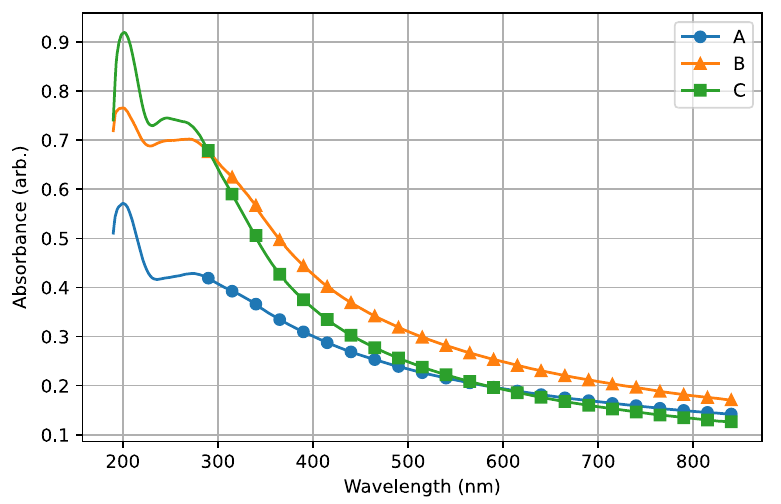
Figure 4 Absorbance spectra of synthesized BTO samples (A), (B) and (C) shows that the samples have increasing absorbance peaks depending on the amount of PEG-6000 added during syntheses.